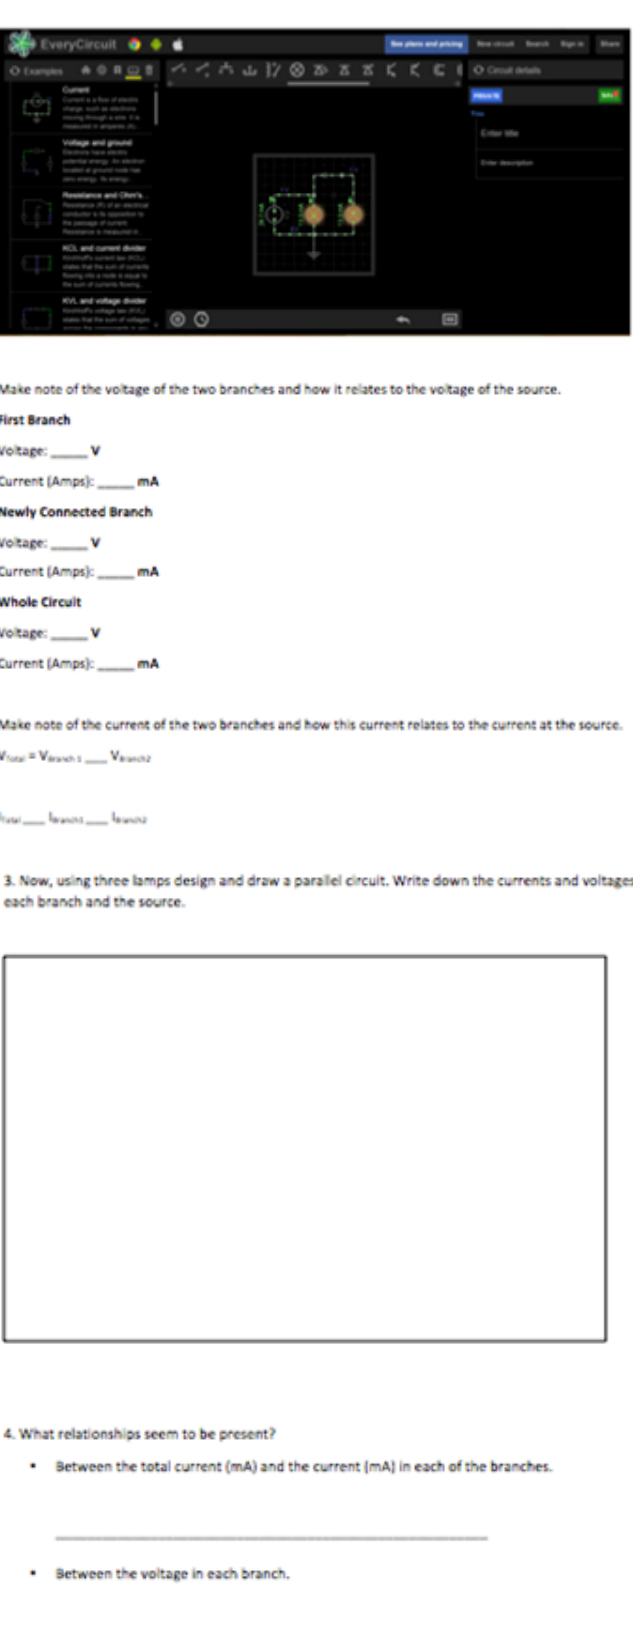
Figure 4. Basic format given to all of the students for the parallel